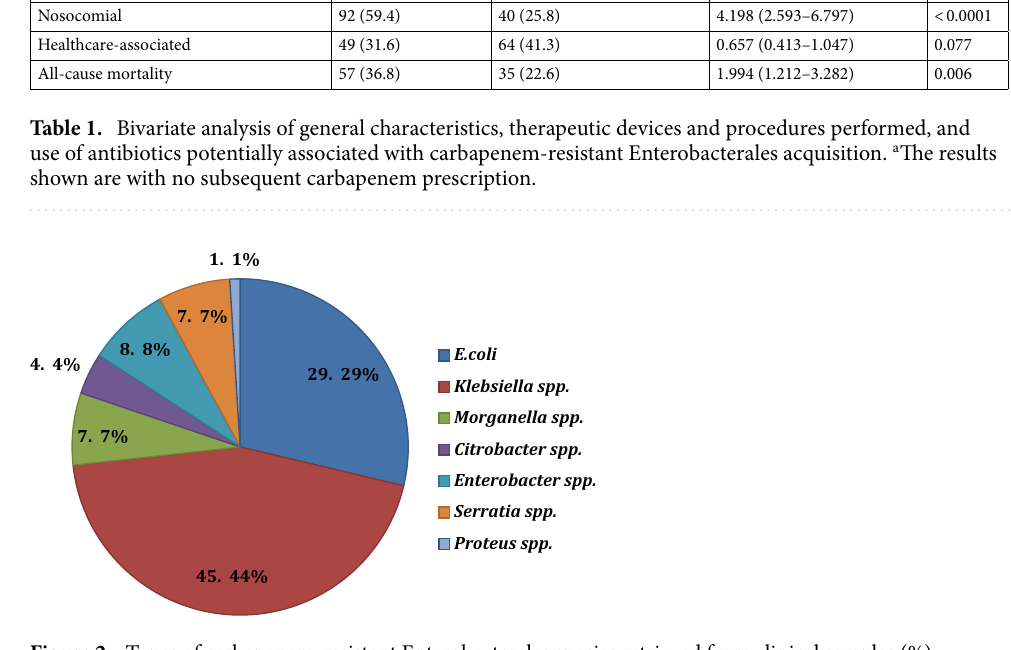
Figure 2. Types of carbapenem-resistant Enterobacterales species retrieved from clinical samples